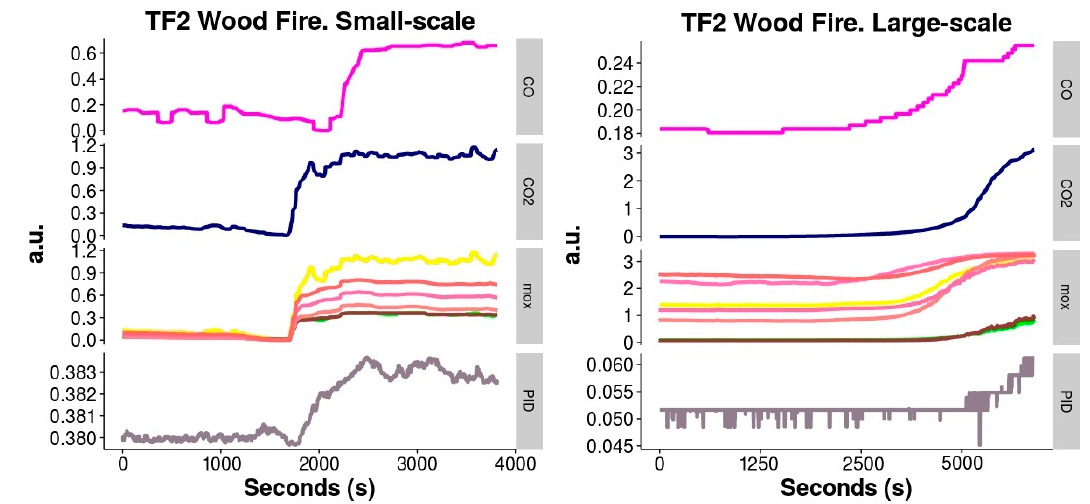
Figure 1. Signals captured for a TF3 experiment (smoldering cotton fire) in the small-scale set up (left) and in the fire room (right). Sensors detect volatiles released during the experiments, however, their reaction is different due to (mostly) the dimensions of the standard fire